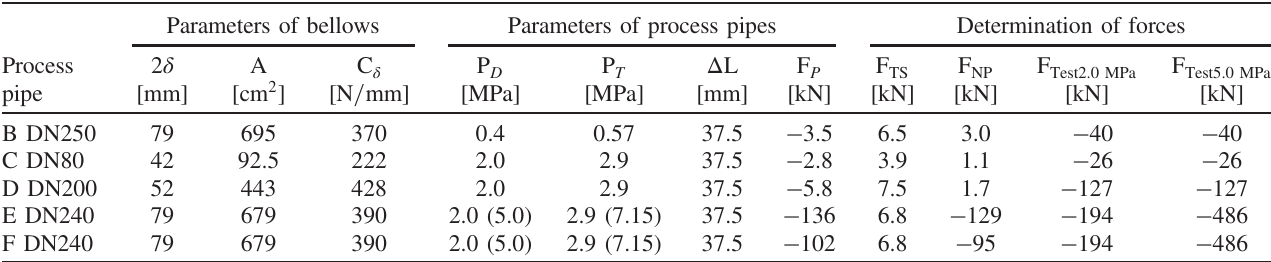
TABLE II. Determining the forces acting on the supports and generated by the compensation bellows. Parameters of bellows Parameters of process pipes